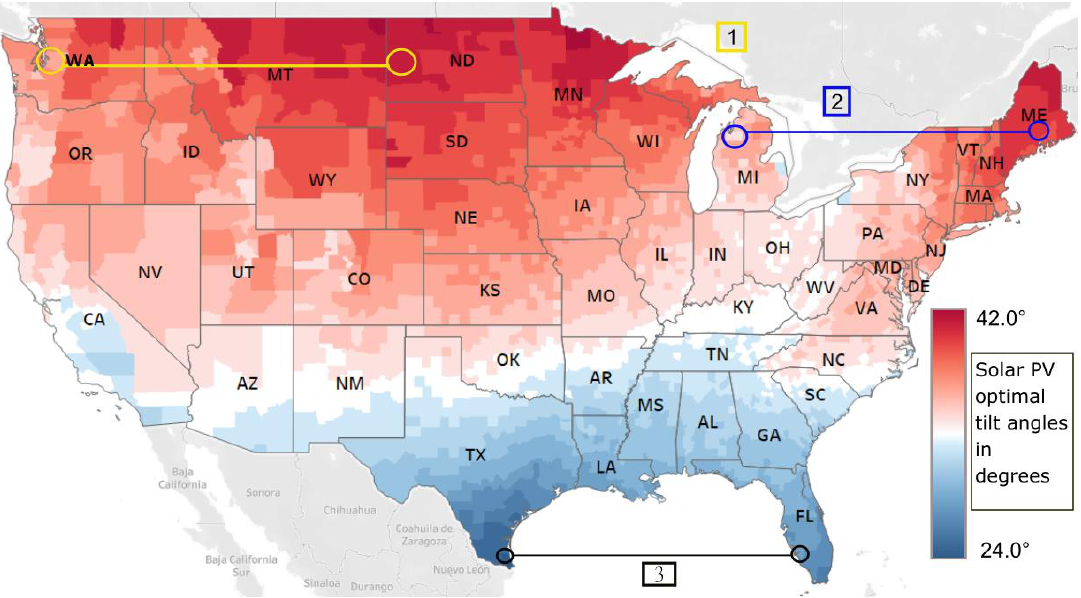
Figure 5. Solar PV optimal tilt angle in degrees for every United States county, showing locations of interest where optimal tilts differ at similar latitudes. The circles connected with lines, labeled with the boxed values 1, 2 and 3, indicate counties of similar latitude that are used for comparison cases.